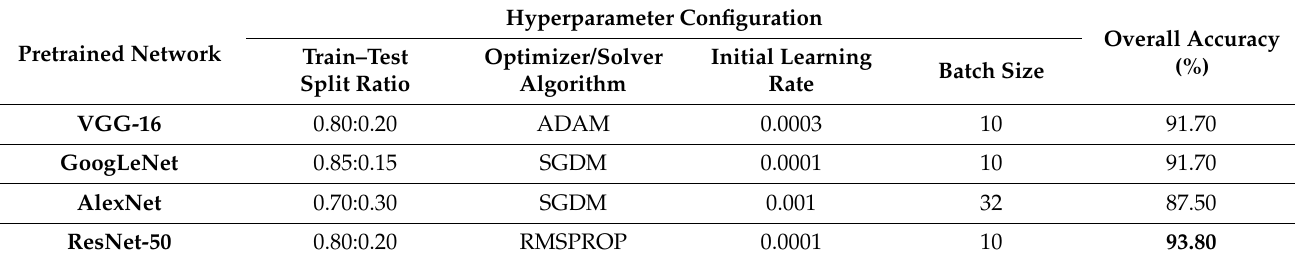
Table 7. Optimal hyperparameters for pretrained model.